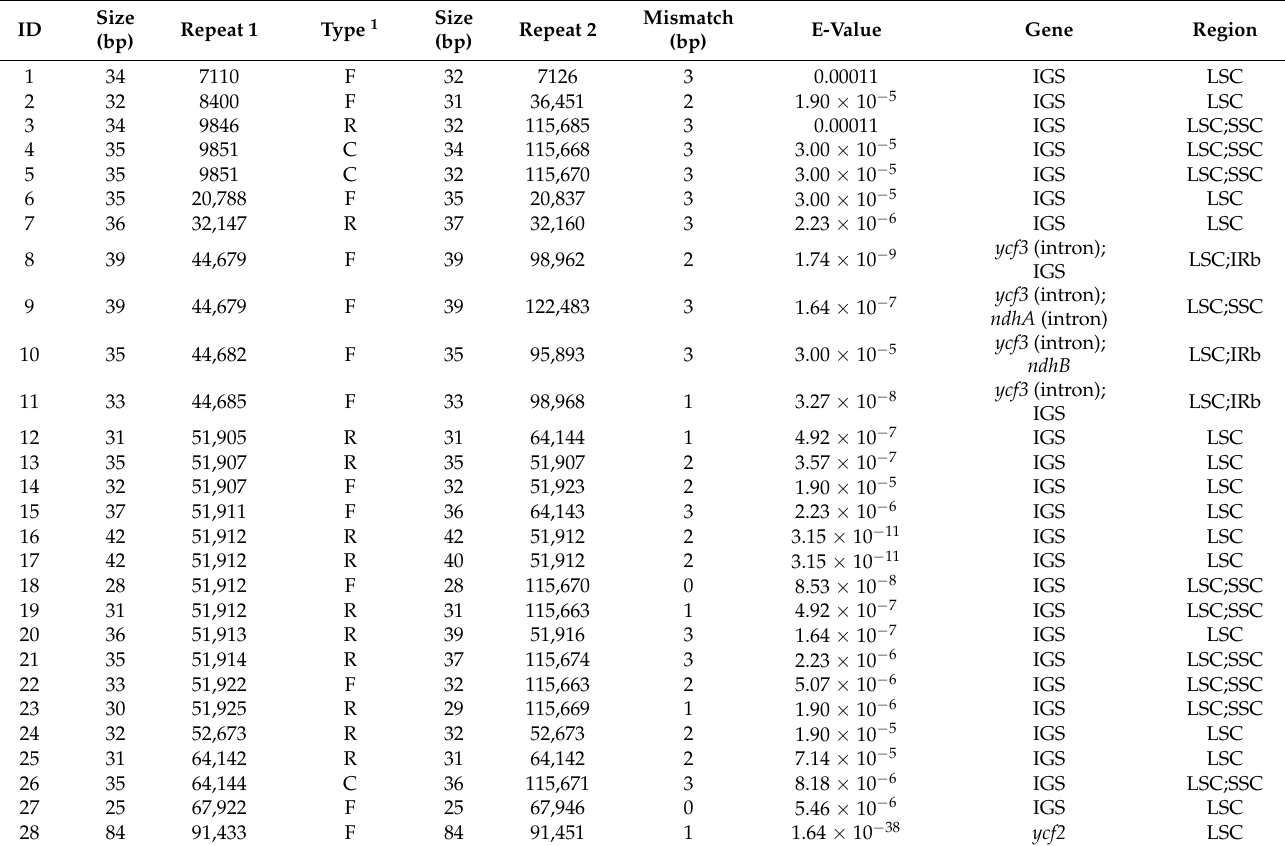
Table 3. Repeat sequences in the chloroplast genome of the wild S. divaricata